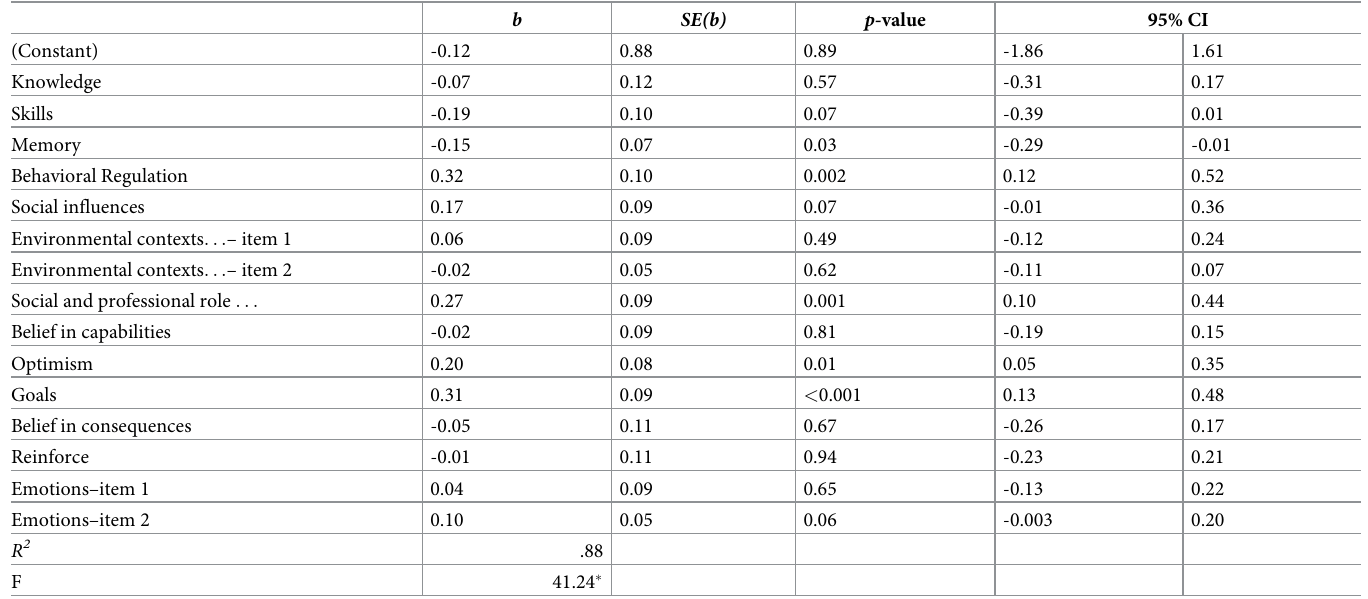
Table 2. Multiple regression predicting ‘Intentions’ composite score from remaining domains: Diagnostic 1 survey about behavioral